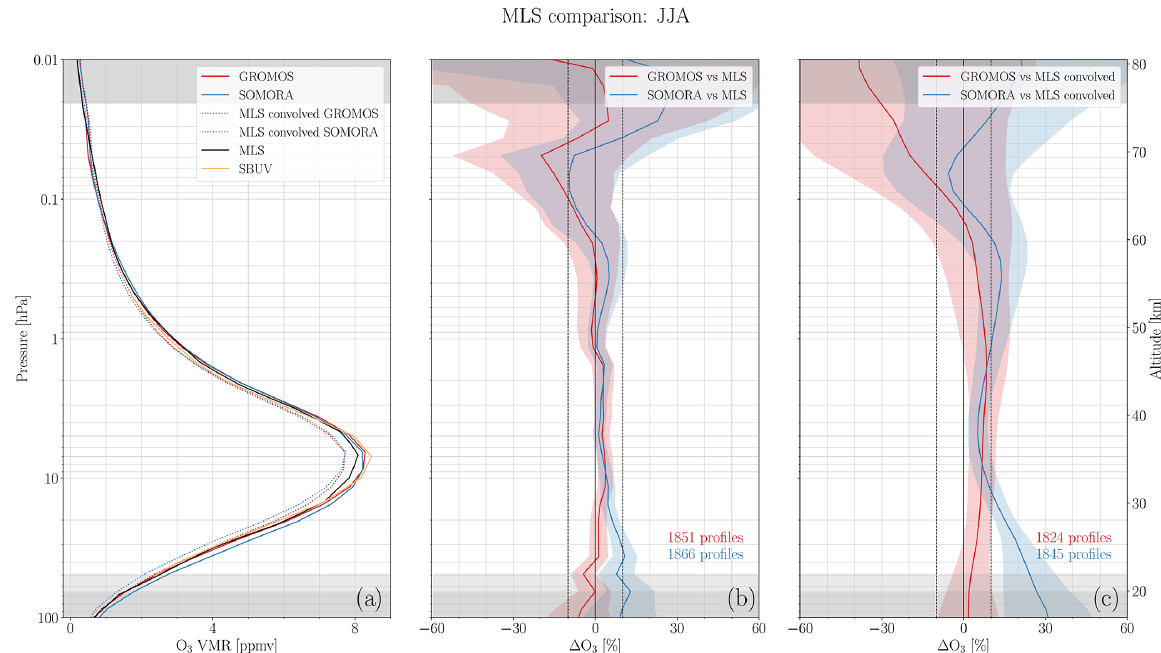
Figure 12. The same as Fig. 11 but for summer (June, July and